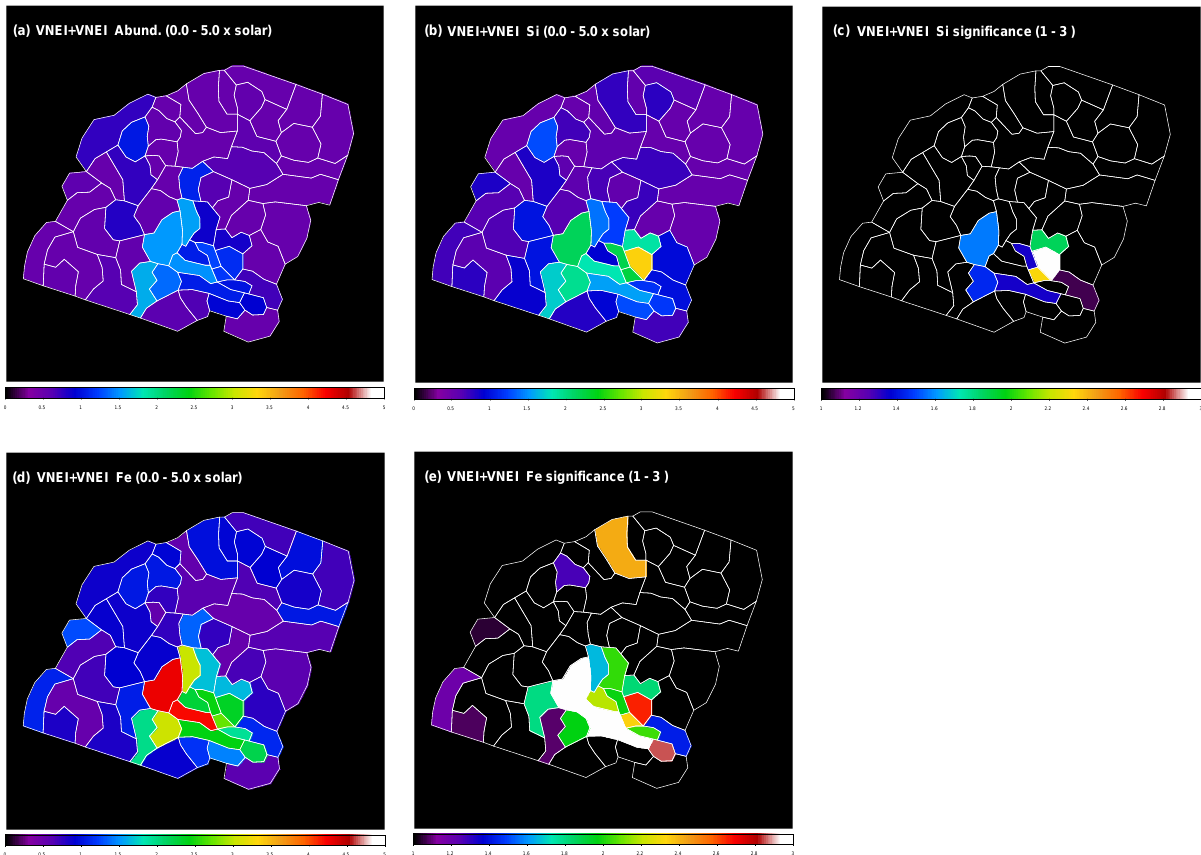
Figure 7: Best fit abundances obtained for the emission of SNR CTB 109 from the analysis of the Chandra ACIS spectra by assuming a thermal model that consists of two VNEI components for thermal non-equilibrium plasma for the shocked ISM and for the shocked ejecta (Sasaki et al., 2013). The shown parameters are: abundances for elements other than Si, S, and Fe fitted for the ejecta emission (a), Si abundance fitted for the ejecta emission (b) and its significance calculated as (abundance of the Si – abundance of the other elements)/error of the abundance of Si (c), Fe abundance and its significance (d and e,